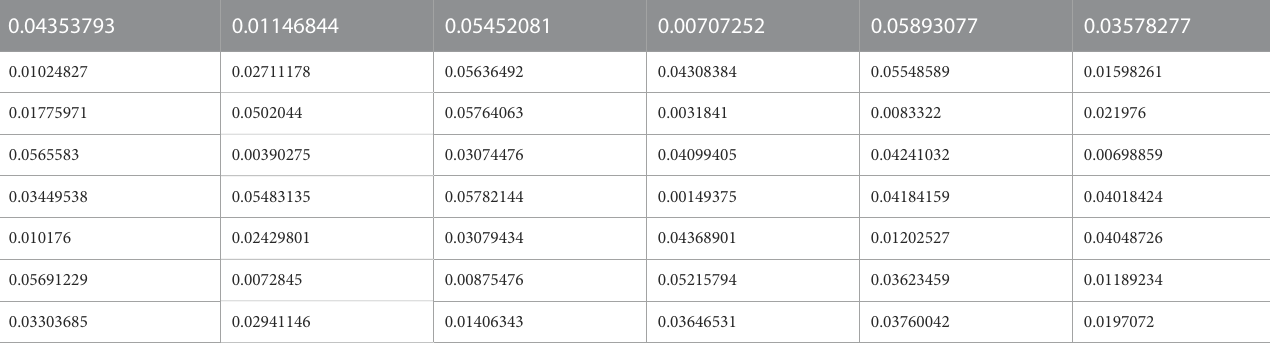
TABLE 2 Generated population randomly.